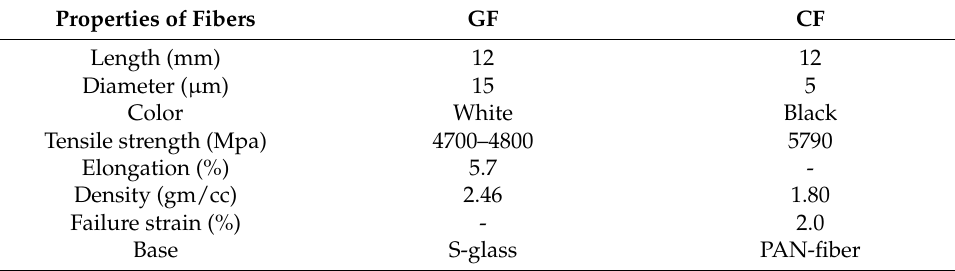
Table 6. Properties of glass and carbon